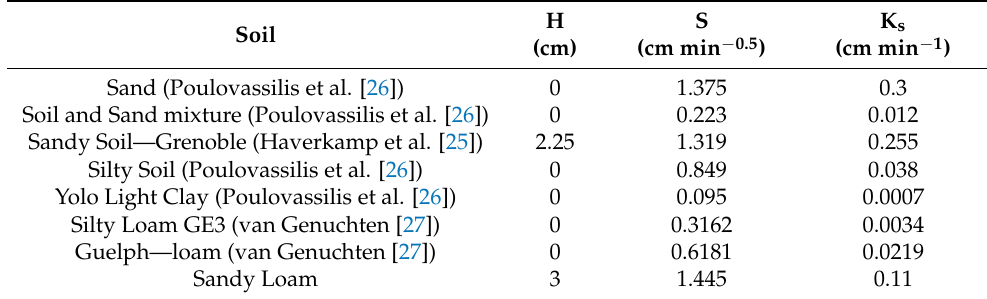
Table 1. Measured or numerical values of saturated hydraulic conductivity, K s , and sorptivity, S, of the studied soils and the corresponding applied pressure heads,